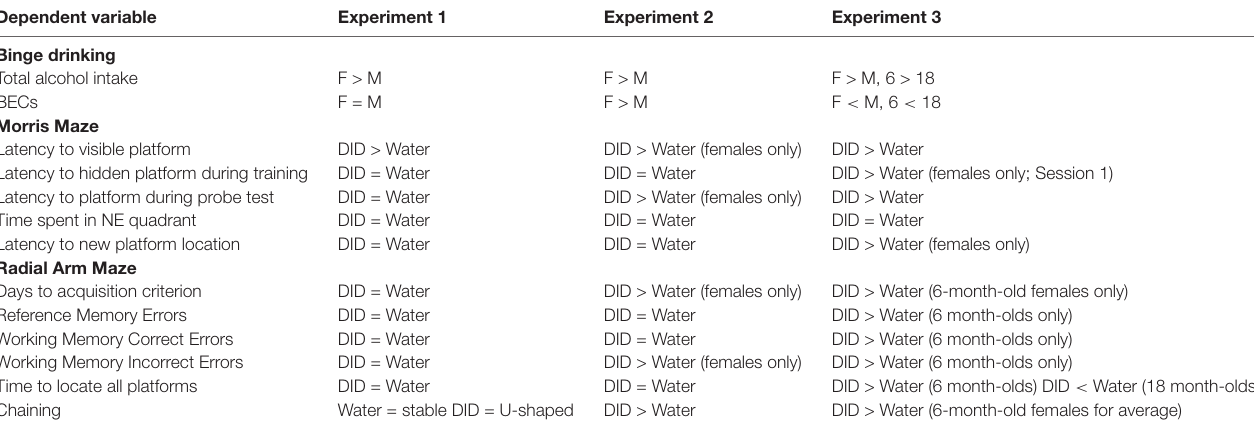
TABLE 2 | Comparison of the effects of a 1-month DID paradigm upon specific behavioral outcomes between Experiments 1 (heterogeneous cohort), 2 (6-month-old B6J mice), and 3 (6- and 18-month-old B6J mice).